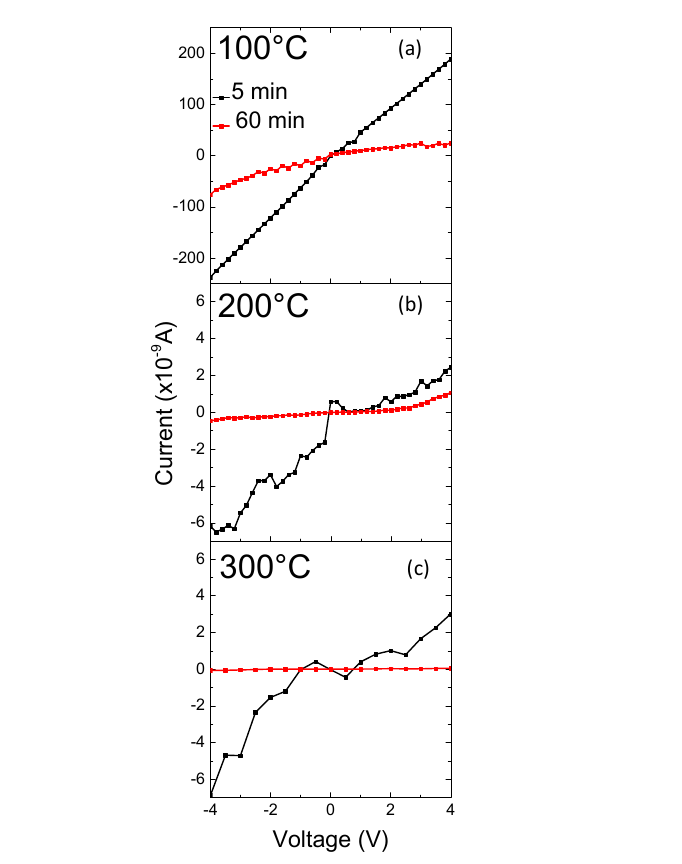
Figure 6. I-V characteristics of ZnO nowalls grown for 5 min (black lines) and for 60 min (red lines) Figure 6 . I-V characteristics of ZnO nowalls grown for 5 minutes (black lines) and for 60 minutes (red after thermal annealing at 100 ◦ C ( a ), 200 ◦ C ( b ), and 300 ◦ C ( c ). lines) after thermal annealing at 100 °C ( a ), 200 °C ( b ), and 300 °C ( c ).